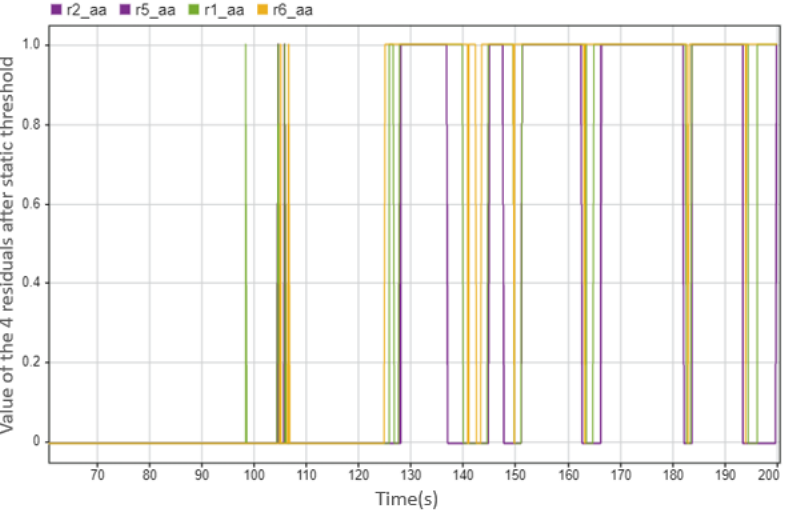
Figure 27. The values of the four residuals after threshold. This case shows when the steering motor 1 fails at 123.5 s (0 means there is no abnormal situation, 1 means there is an abnormal